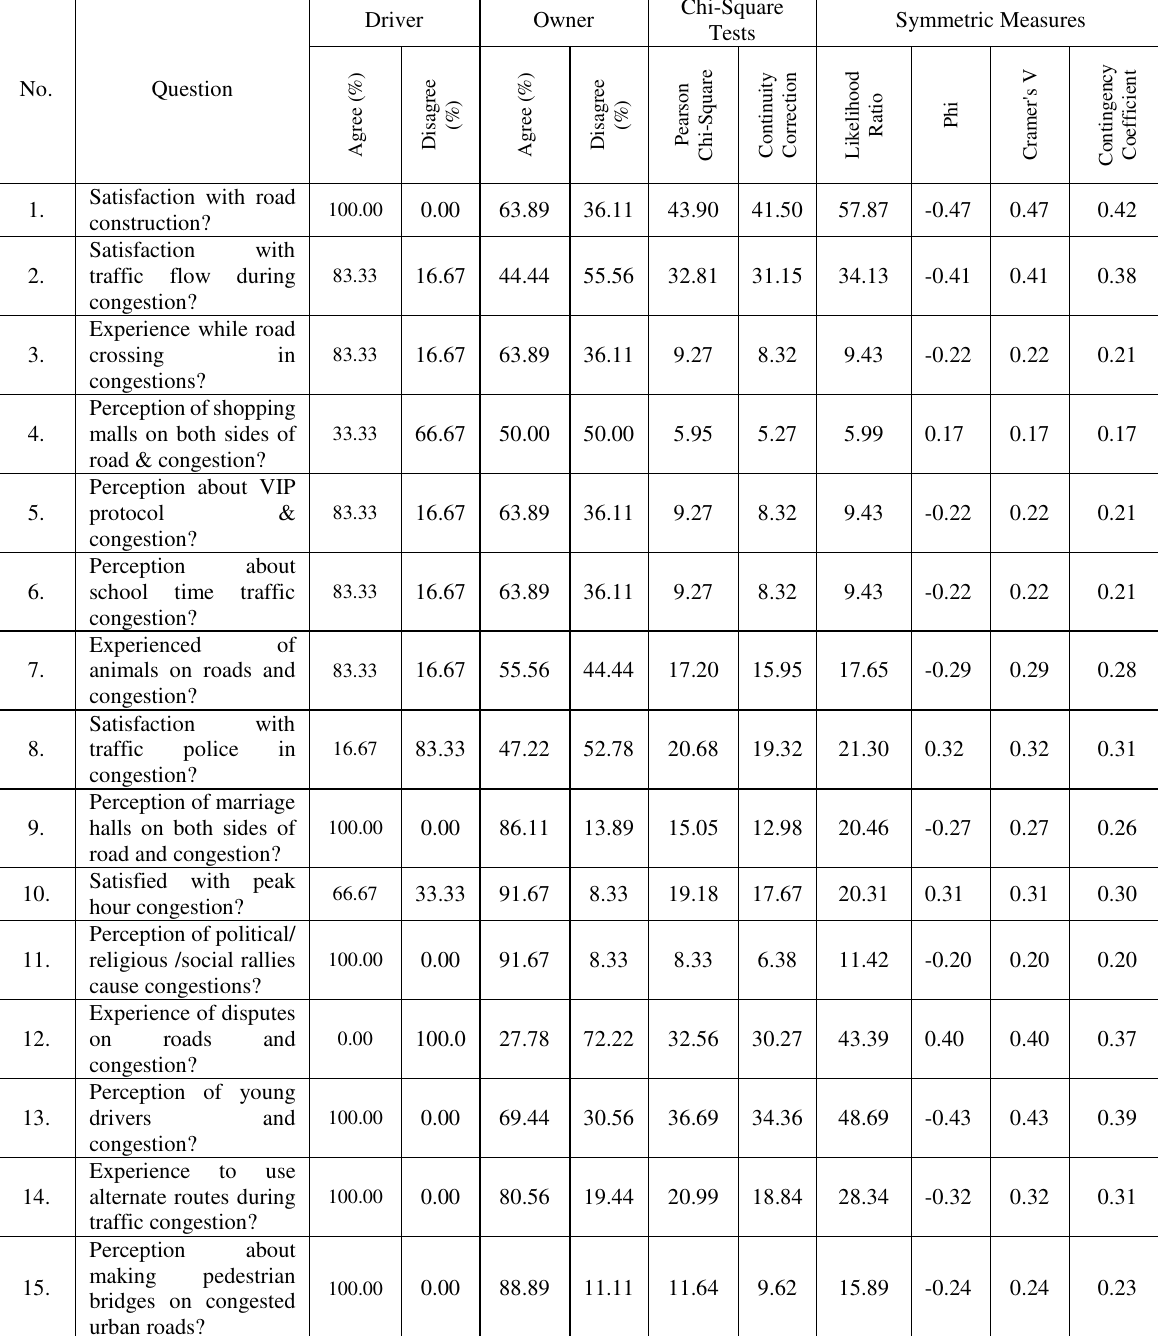
TABLE 4: ESTIMATED RESULTS OF ALL POTENTIAL MODEL VARIABLES OF TRAFFIC CONGESTION WITH RESPECT TO CAR DRIVERS/OWNERS WITH THEIR CUMULATIVE COMPARISON AND STANDARDISED EFFECTS